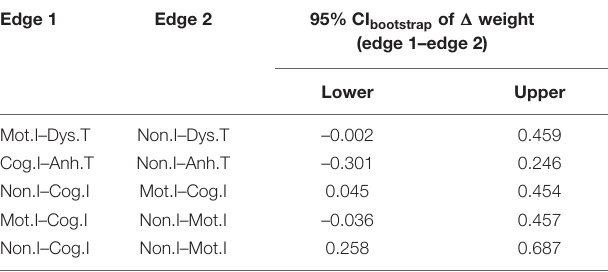
TABLE 2 | Edge weight